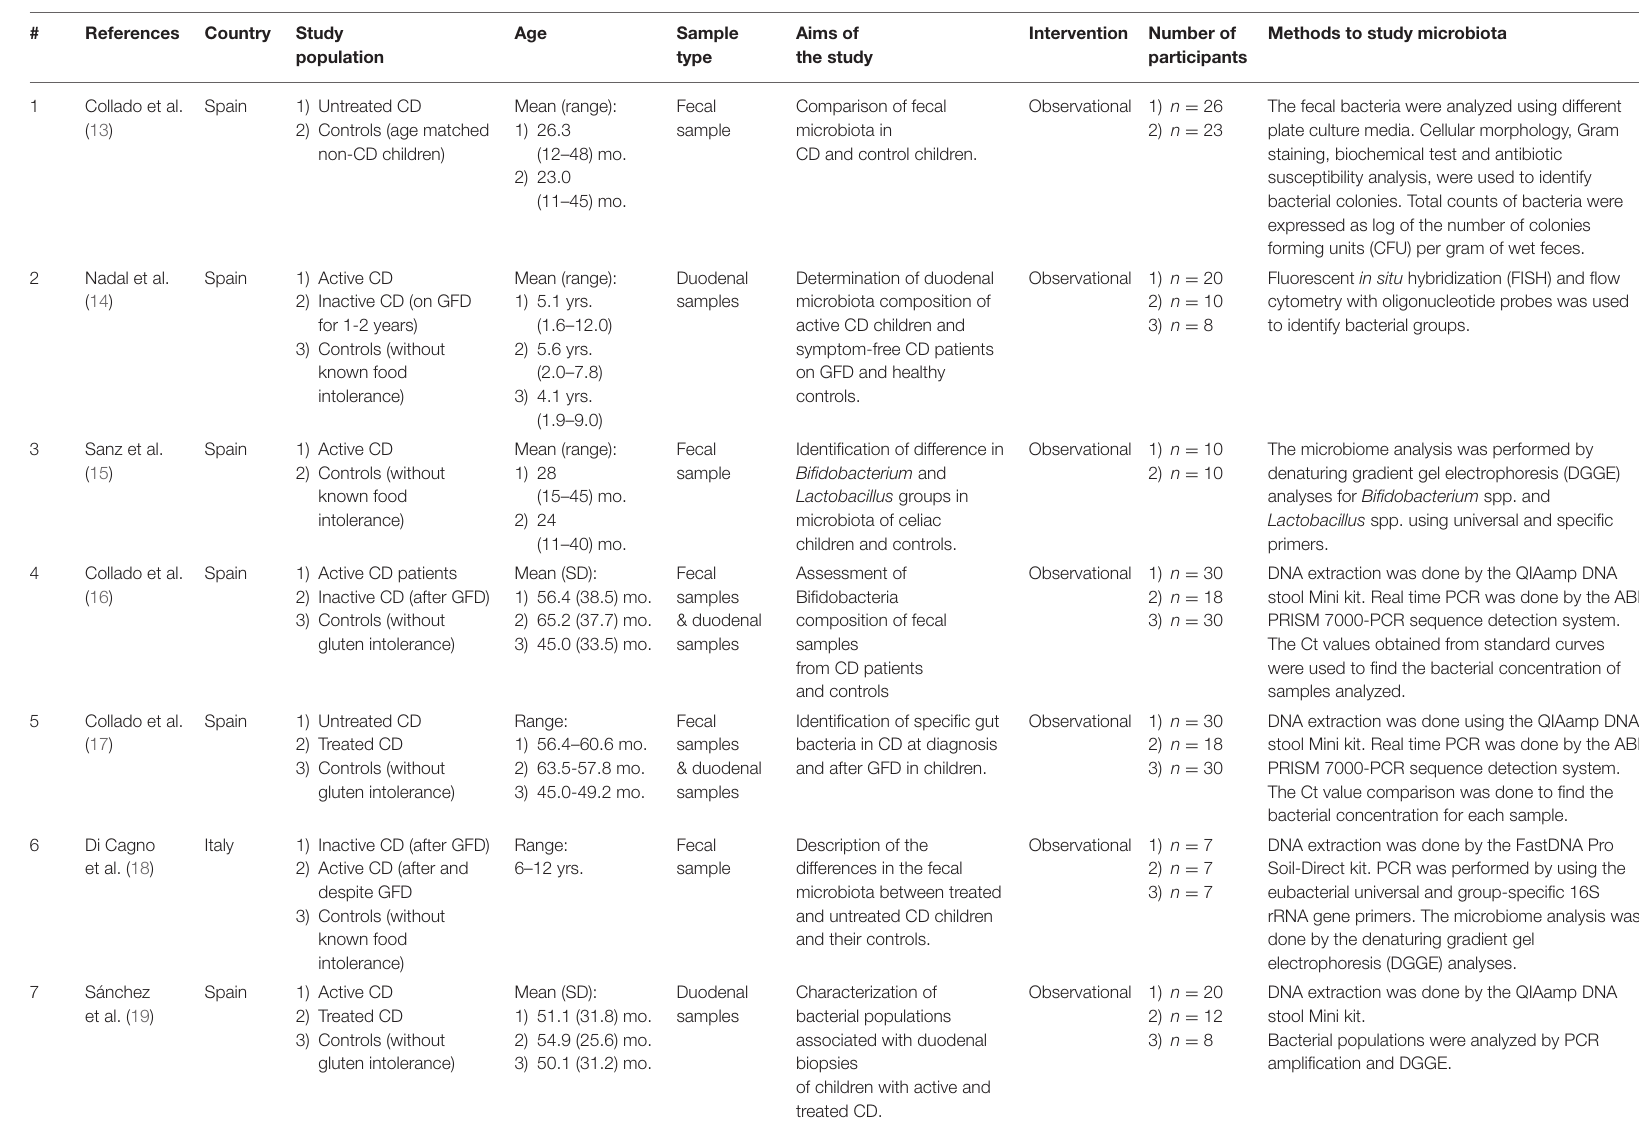
TABLE 2 | Overview of the articles included in the systematic